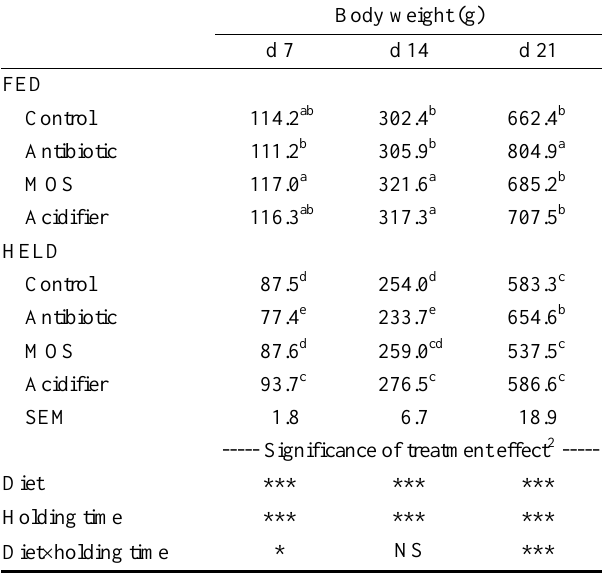
Table 2. Effects of post hatch holding time and dietary supplements on body weight at d 7, 14 and 21